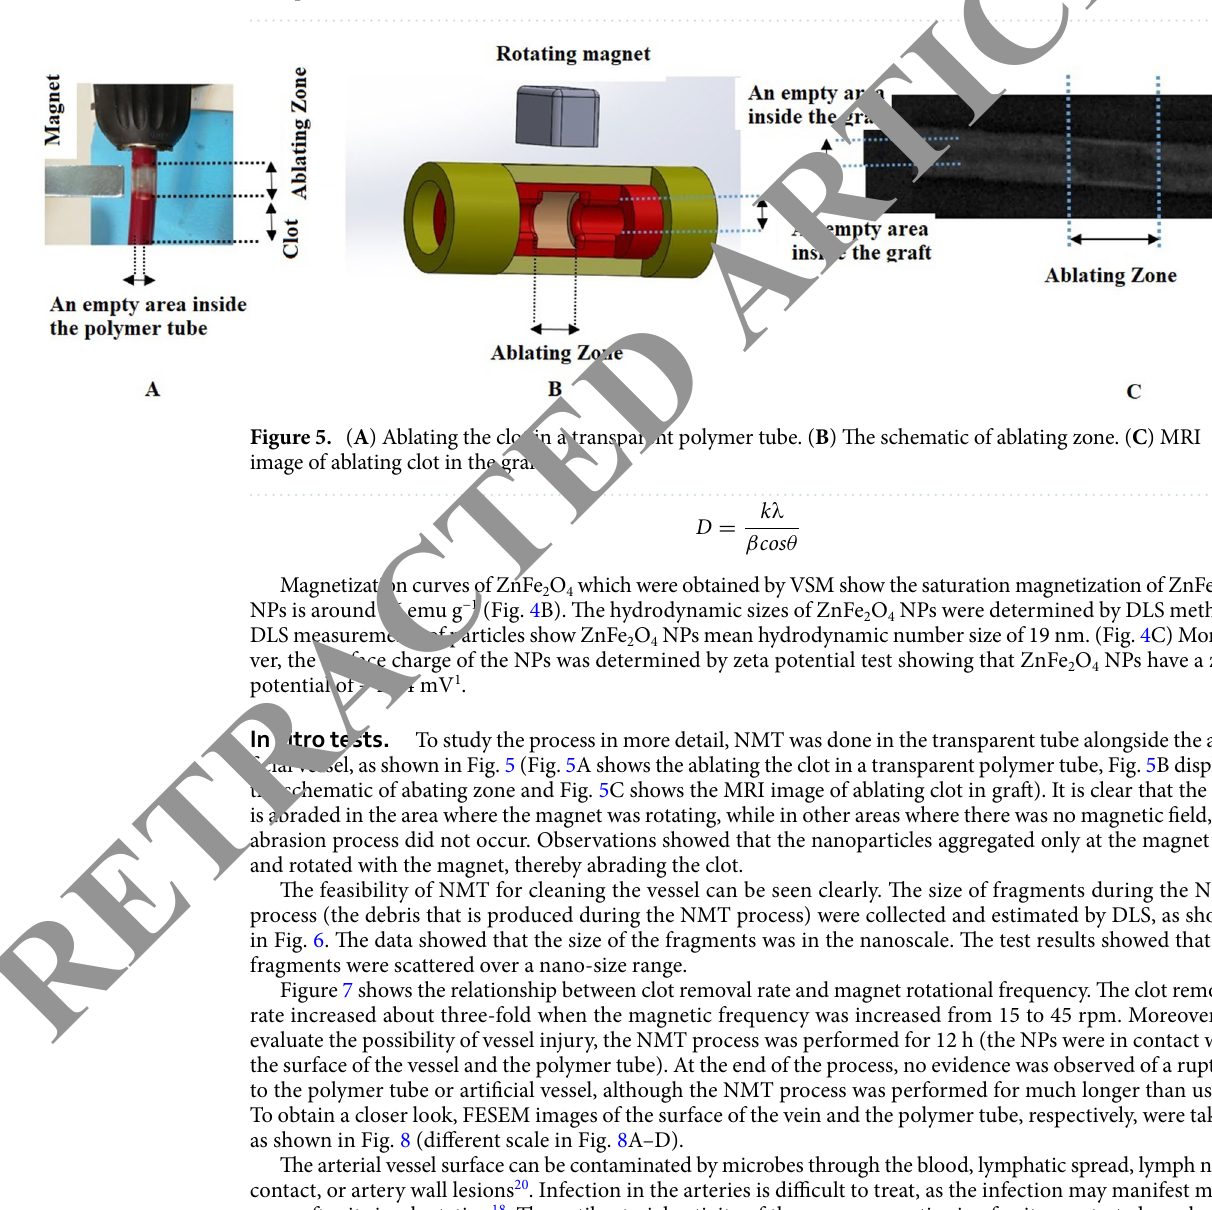
Figure 4. ( A ) XRD, ( B ) VSM analysis of nanoparticles and ( C ) the hydrodynamic size of magnetic nanoparticles.